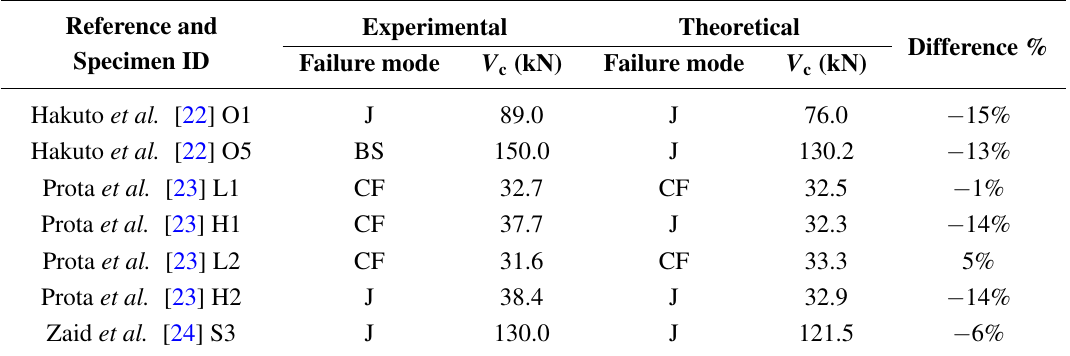
Table 6. General validation of model by means of comparison of experimental outcomes and simplified model